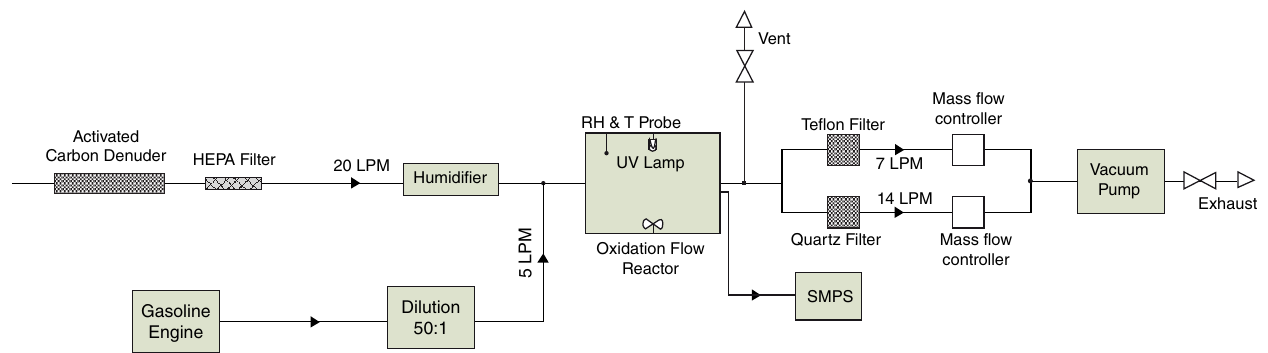
Figure 2. Anthropogenic (gasoline engine exhaust) particulate matter (PM) sampling setup.